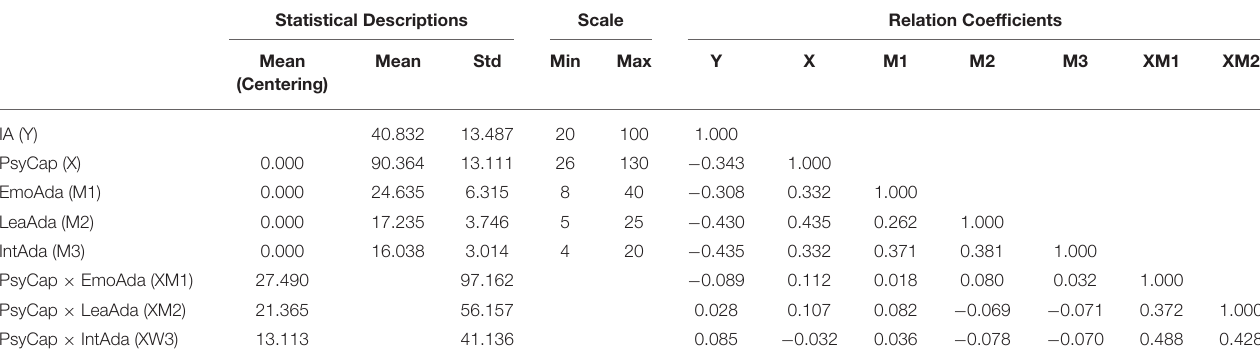
TABLE 2 | Statistical descriptions and relation coefficient matrix.